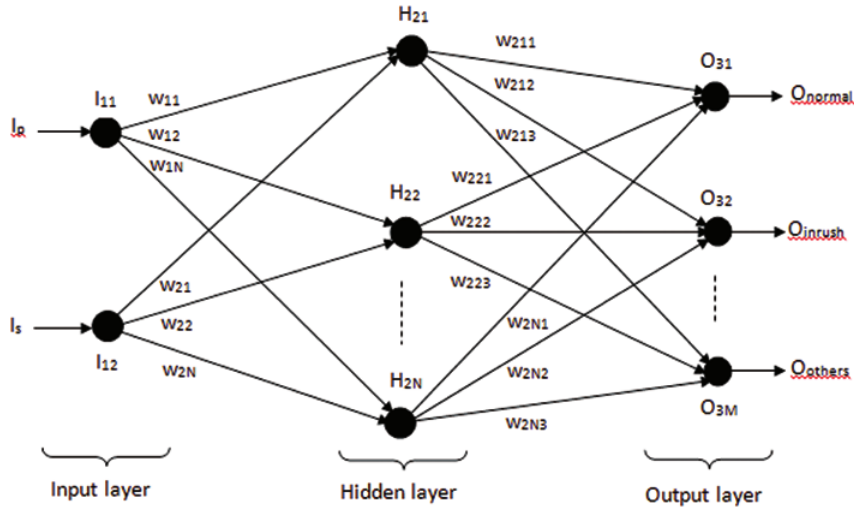
Figure 3: Neural Network